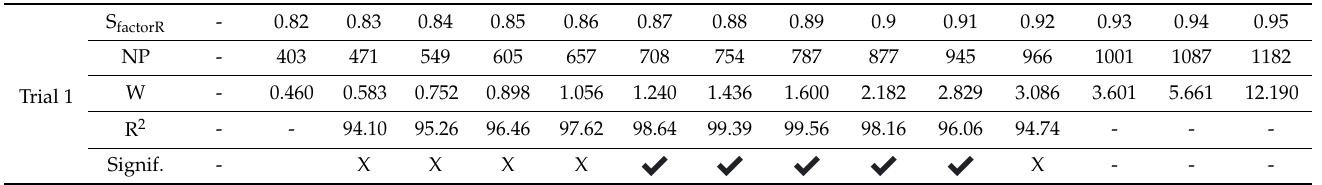
Table 3. Model fitting for choice of S factor in the 6 patients. Table 2. Model fit for choice of S factor in Trial 1.